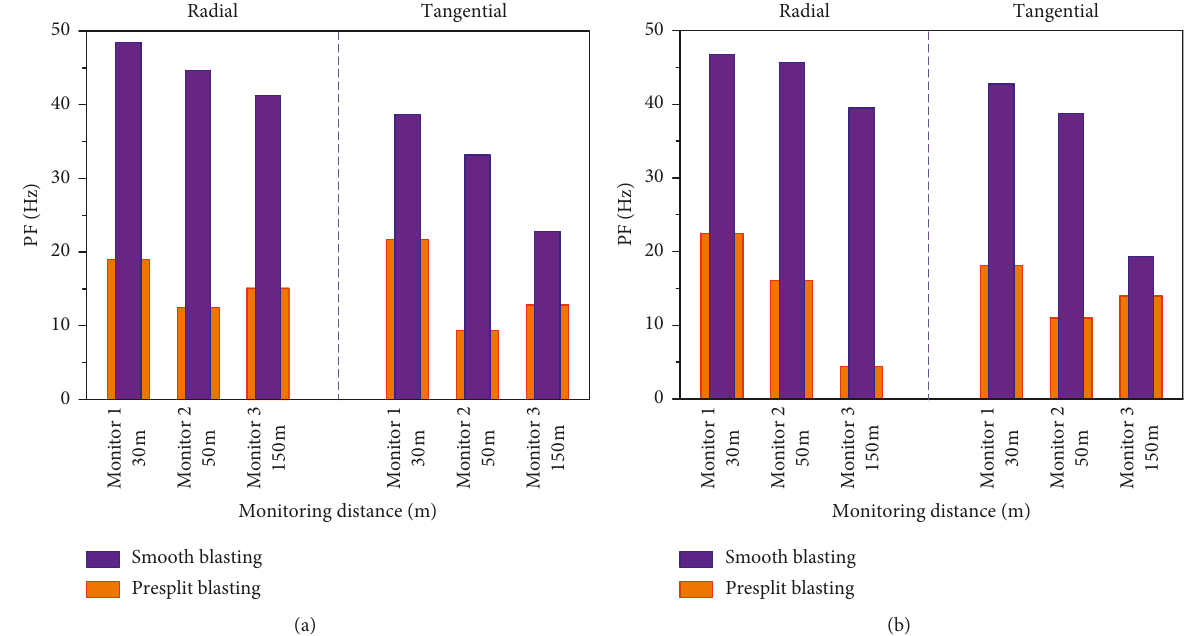
Figure 8: The principal frequencies of vibration signals from (a) main and (b) peripheral boreholes versus monitoring distances based on presplit and smooth blasting.